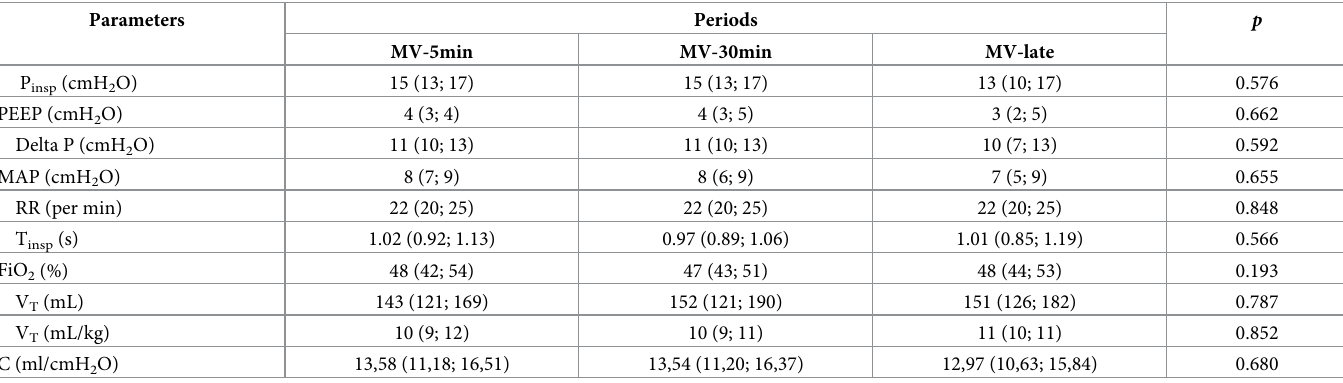
Table 2. Mechanical ventilation parameters in 20 pediatric patients, by time of